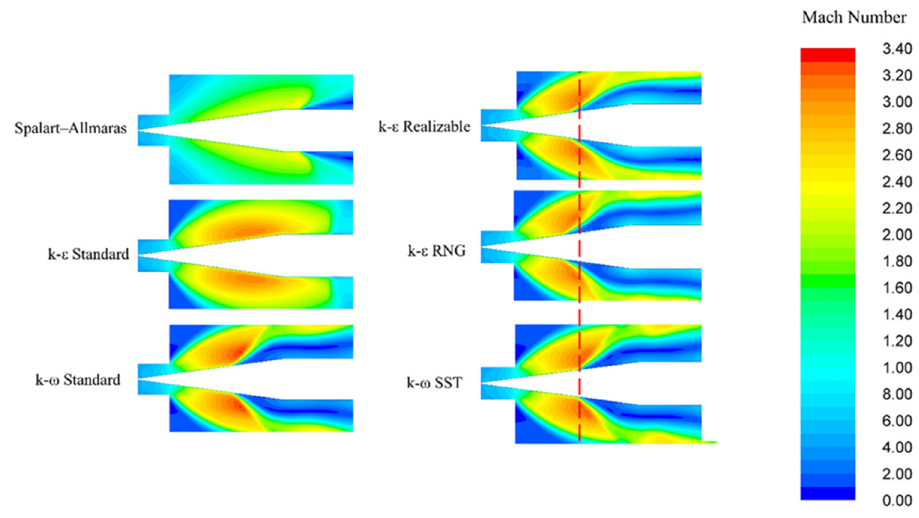
Figure 6. Mach number contours for ejected flows from the micro nozzle for different turbulence models.